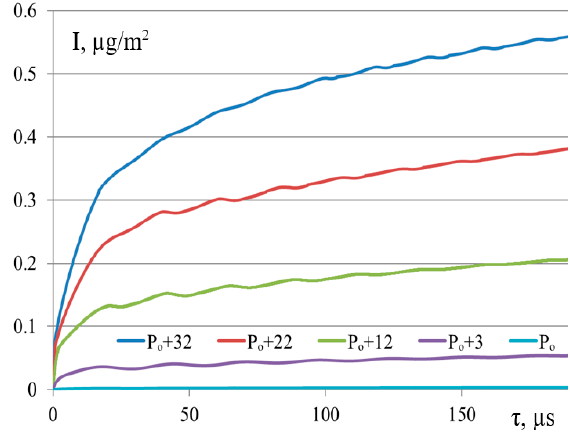
Figure 9. Effect of gas pressure increase relative to the equilibrium level of the methane hydration processes (P, bar) (equilibrium values are shown in Table 1).